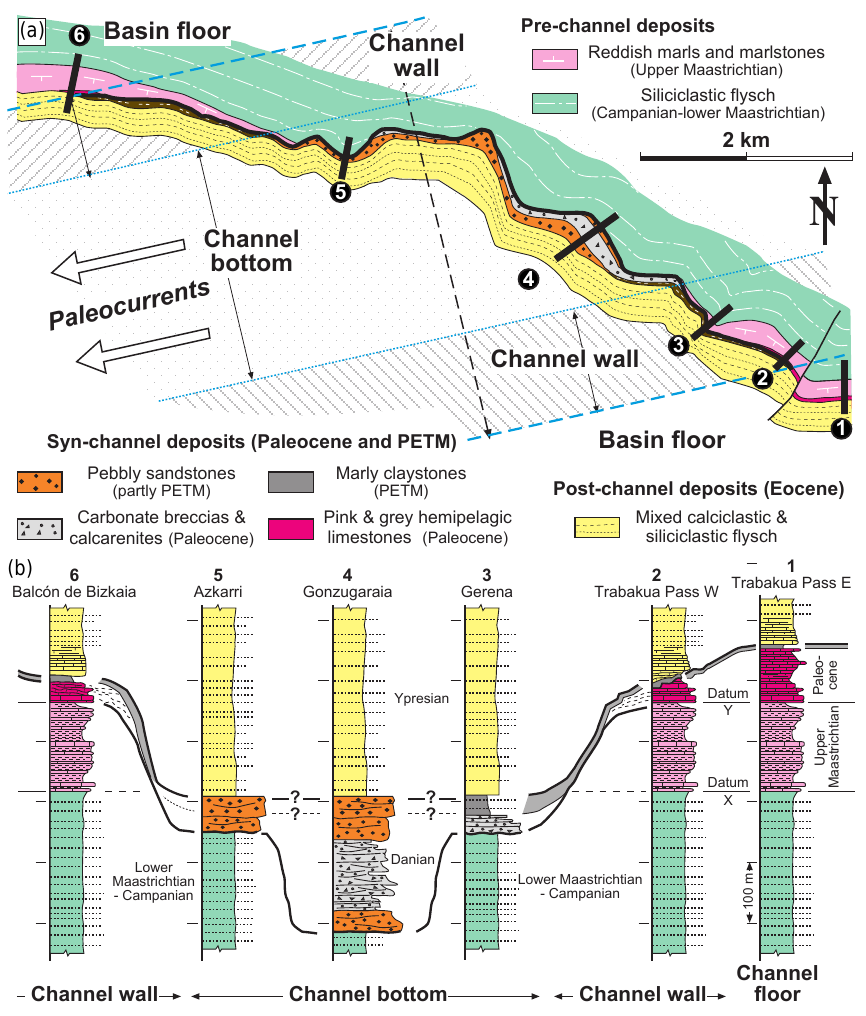
Figure 8. Panel (a) : outcrop map with superimposed paleogeography of a segment of the Paleocene deep-sea channel from the Gonzugaraia– Trabakua pass area (location: box 3 in Fig. 1). Panel (b) : correlation of representative upper Cretaceous–Eocene sections using two datums: X – lower–upper Maastrichtian boundary; Y – Cretaceous–Paleogene boundary. Note that PETM clays drape the channel walls (Trabakua pass west and Balcón de Bizkaia sections) and the basin floor (Trabakua pass east